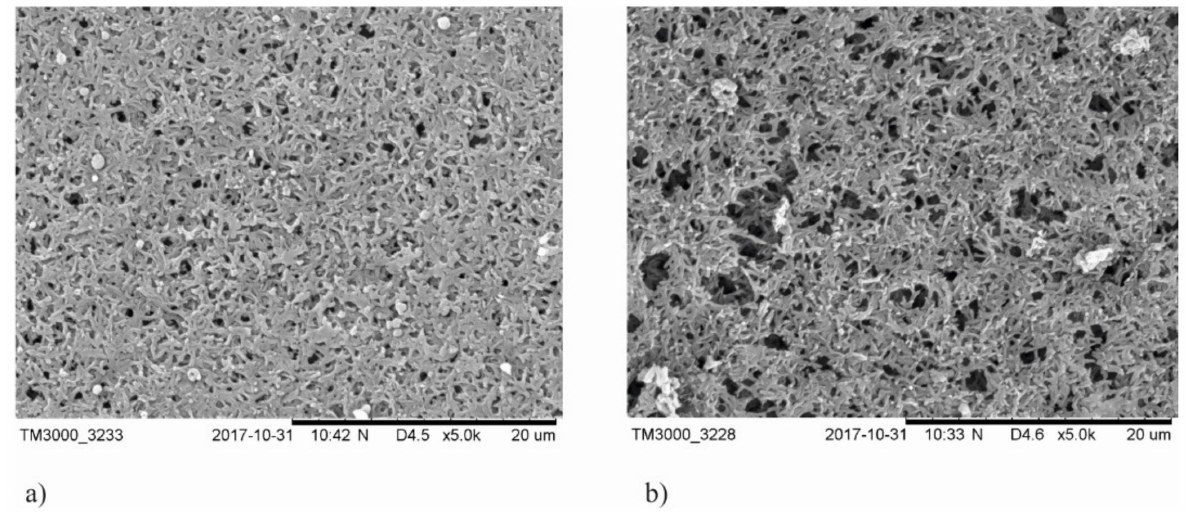
Figure 2. SEM images of the non-coated membranes in two characteristic areas with different pores sizes: ( a ) area with a high proportion of small irregular pores; ( b ) area with a high proportion of large spherical pores.